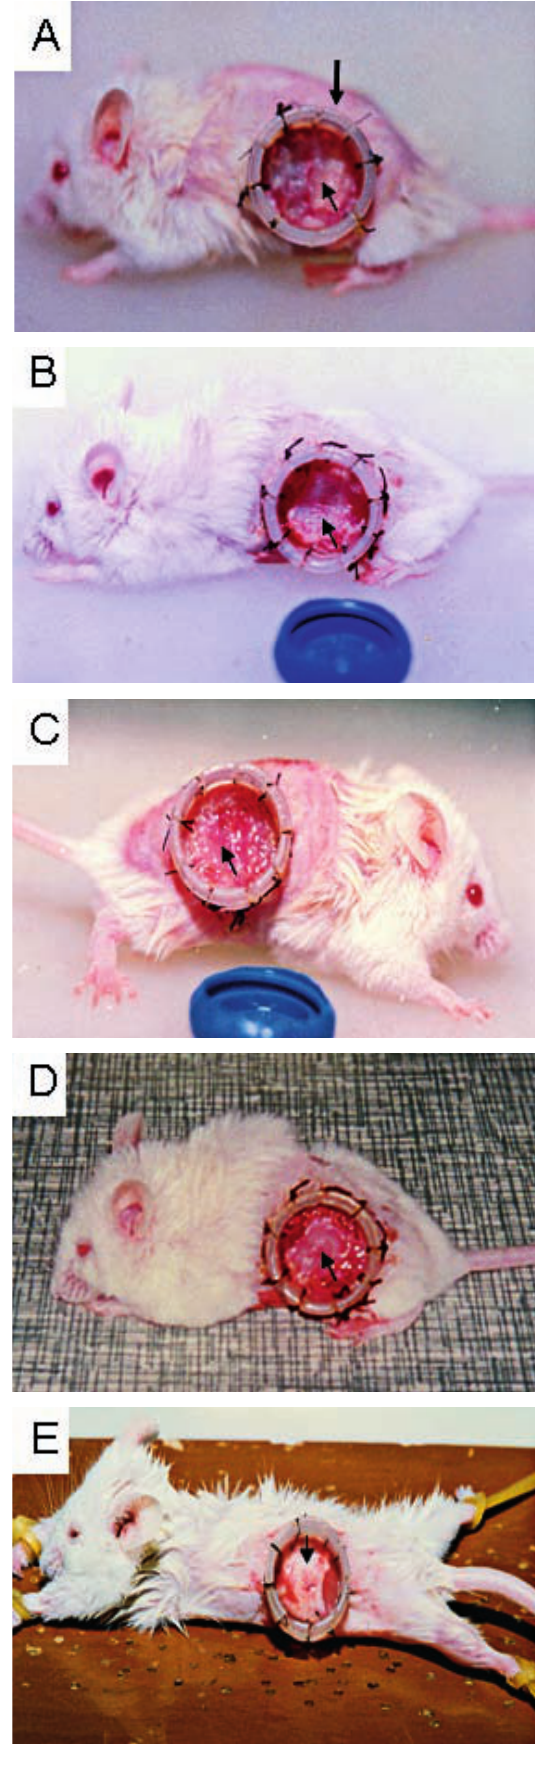
(A) At 4 weeks after composite skin trans- plantation, an epider- mal layer is evident in group 1 (small arrow); the large arrow indicates the graft chamber. In group 2, 3 and 4 (B, C, D), an epider- mal layer is also seen (arrow), which is not significantly different from that in group 1. In group 5 (E), the epidermal layer is completely rejected, where ADM is ex- posed, vascularised and closely adheres with the wound